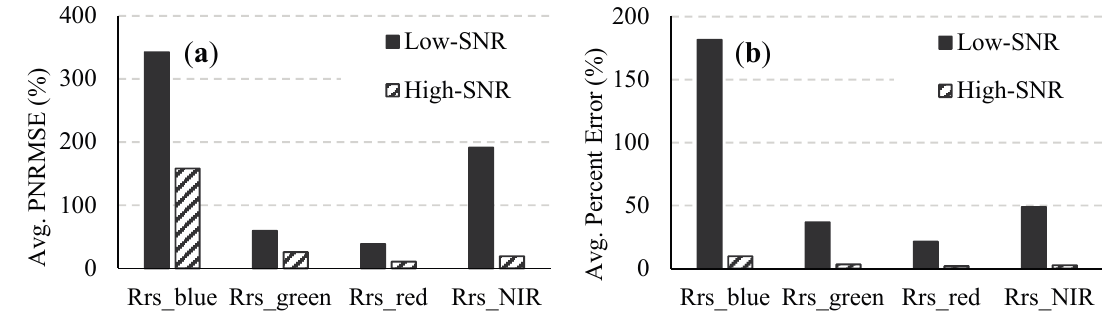
Figure 4. Average ( a ) PNRMSE and ( b ) percent error of C wvap and τ 550 retrieved from all 490 images for the low- and high-SNR systems.